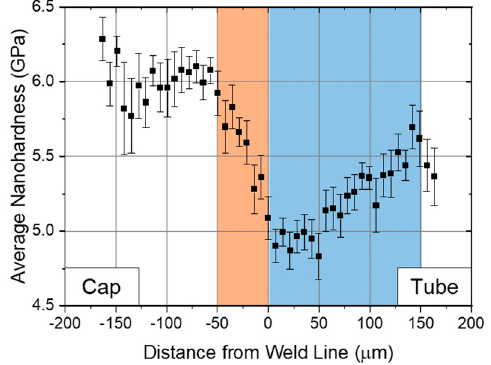
Figure 8. Nanoindentation measurements with distance from the weld lines of CDRW joints, based on 720 measurements across six joints produced using Weld Conditions 1–3. Note the expected difference in hardness between cap and tube materials (~6.0 vs. ~5.5 GPa) and the noticeable softening of material in the cap and tube TMAZs (shaded).